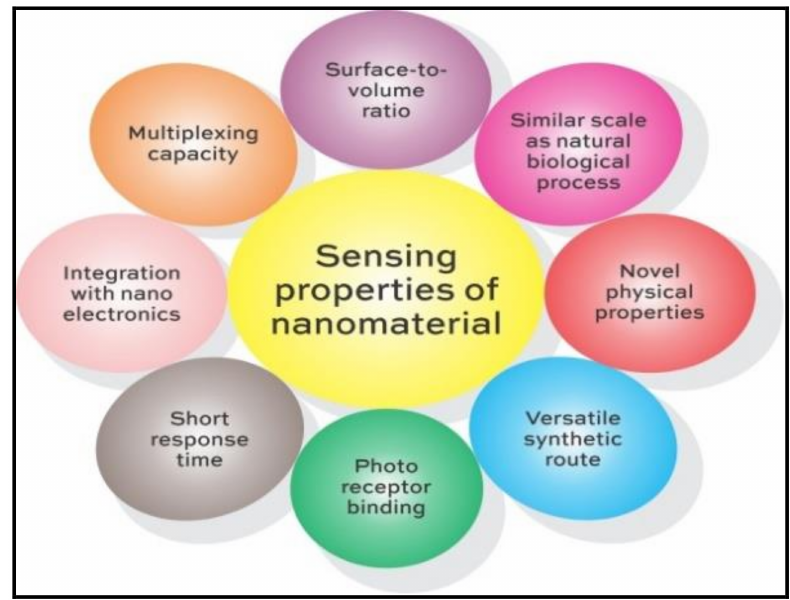
Figure 1. Relevant properties of nanomaterial in view of sensing